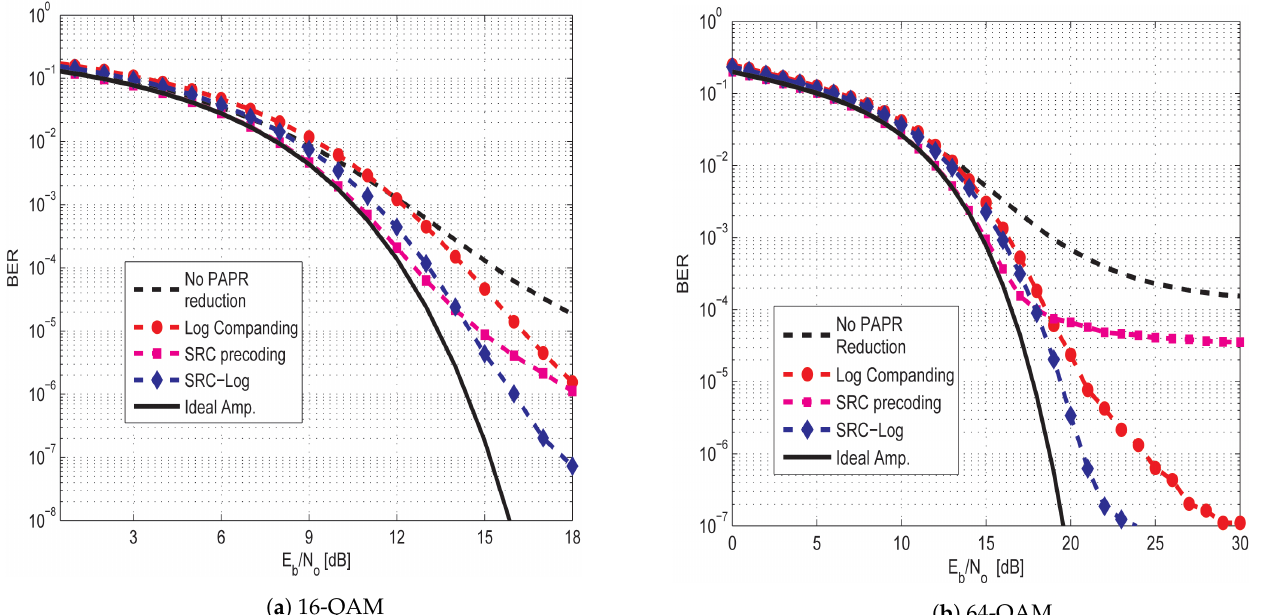
Figure 4. BER performance of SRC-Log in AWGN channel in comparison with SRC precoding and Log companding, along with OFDM w/o PAPR reduction. The case of an ideal amplifier is shown in a solid line.